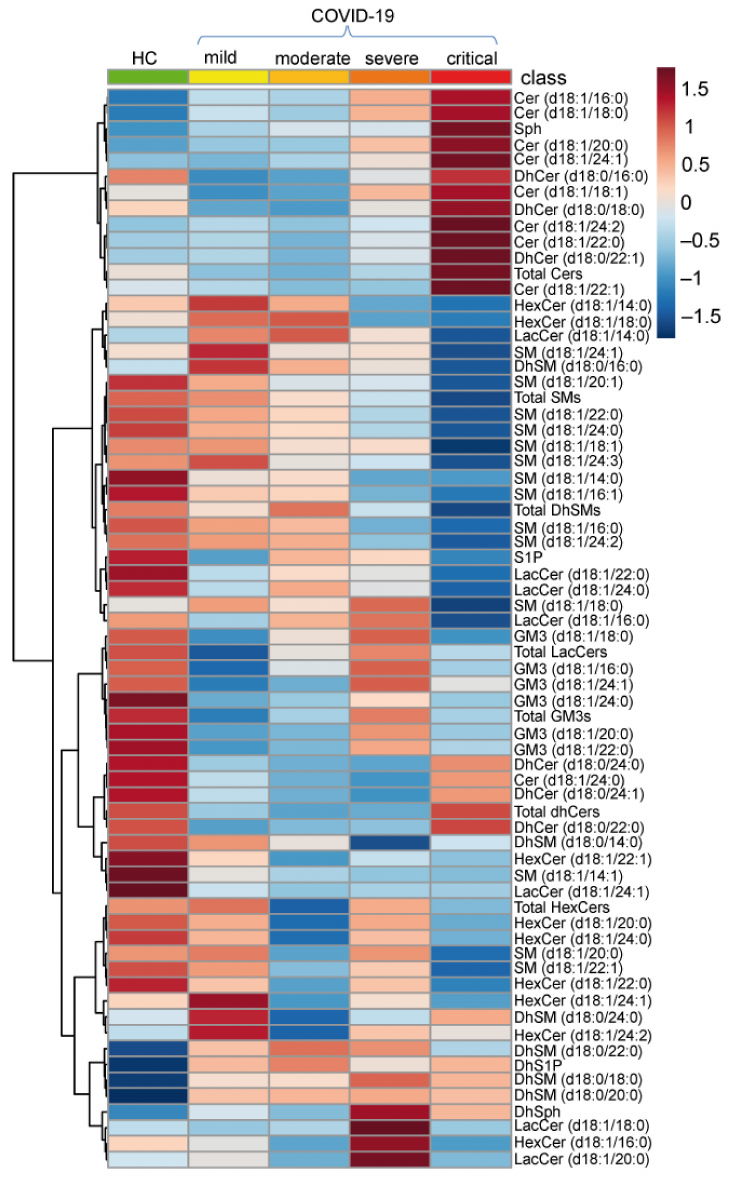
Figure 1. Heatmap of hierarchical clustering of the 68 sphingolipids quantified by LC-MS/MS in healthy controls (HC) and in COVID-19 patients (mild, moderate, severe, critical). Sphingolipids’ average abundances for each class are